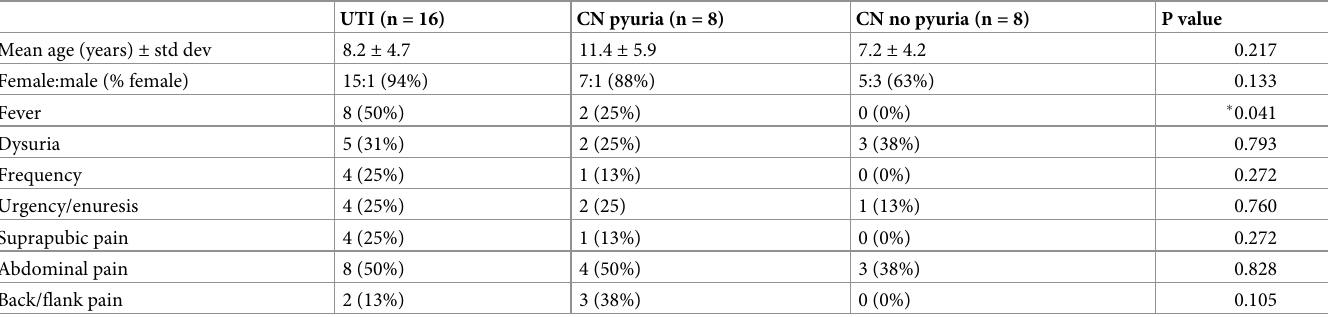
Table 1. Epidemiology and presenting symptoms^ of